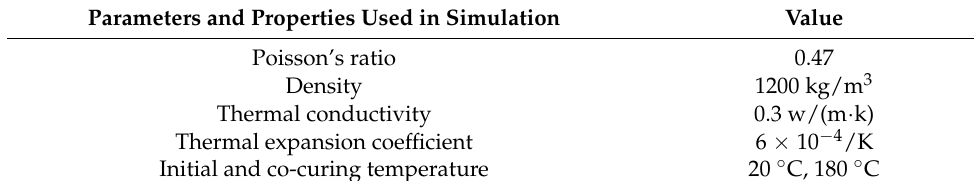
Table 4. Simulation parameters and properties.